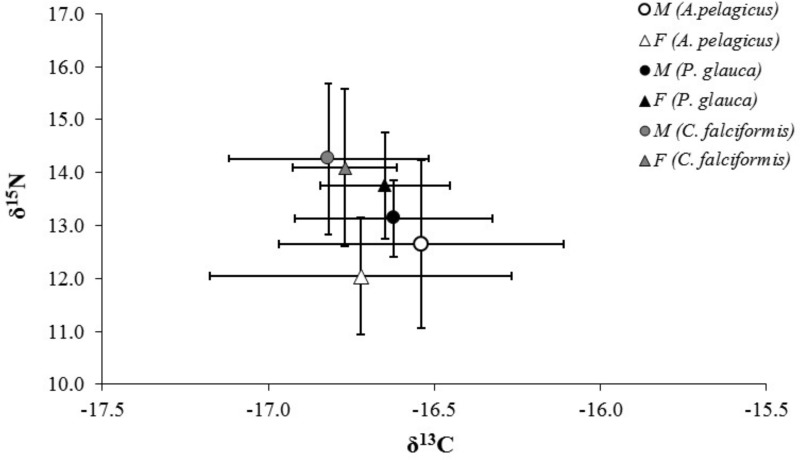
Values of δ13C and δ15N in the muscle tissue of males and females of three shark species.Values of δ13C and δ15N (expressed in ‰; mean ± SD) in the muscle tissue of males and females of A. pelagicus, P. glauca and C. falciformis in the Galapagos Marine Reserve.